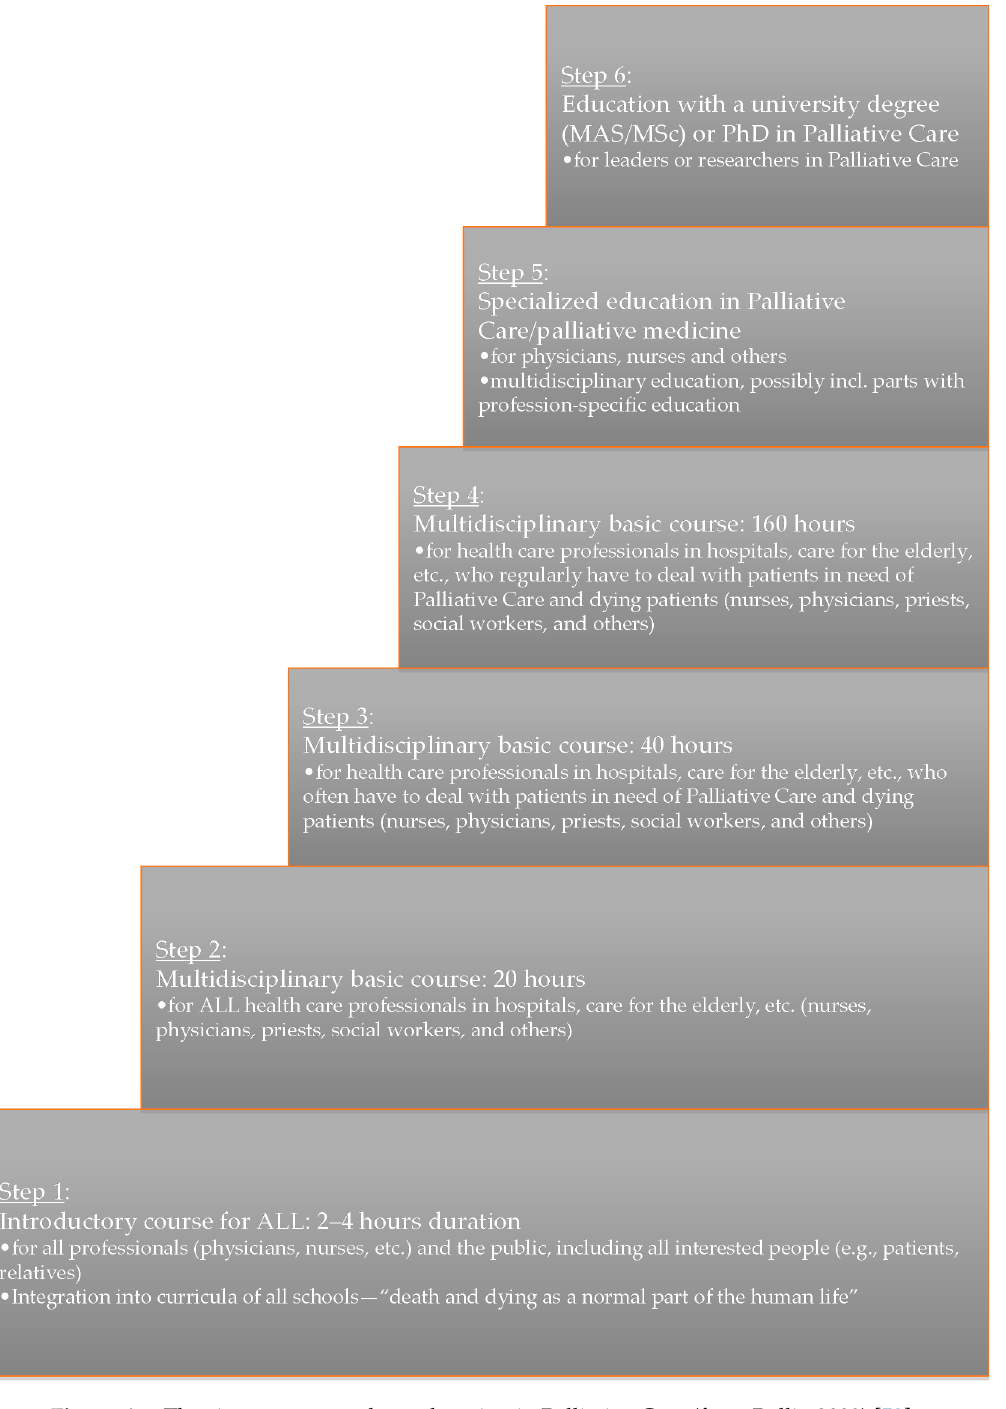
Figure A2. The six-step approach to education in Palliative Care (from Bollig 2009) [52]. Table A1. The Last Aid course contents (version May 2018). Last Aid Care for seriously ill and dying people at the end of life.